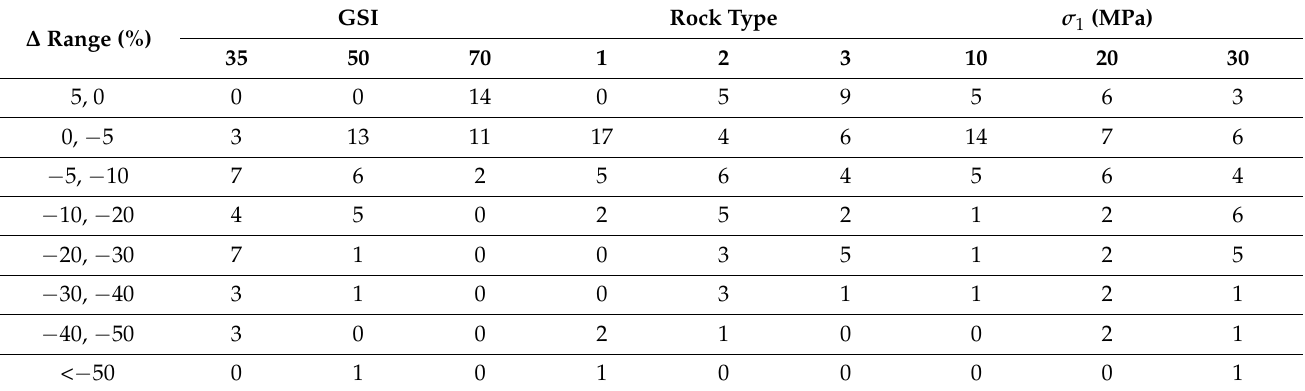
Table 4. Number of cases for the various error ranges of maximum displacement.